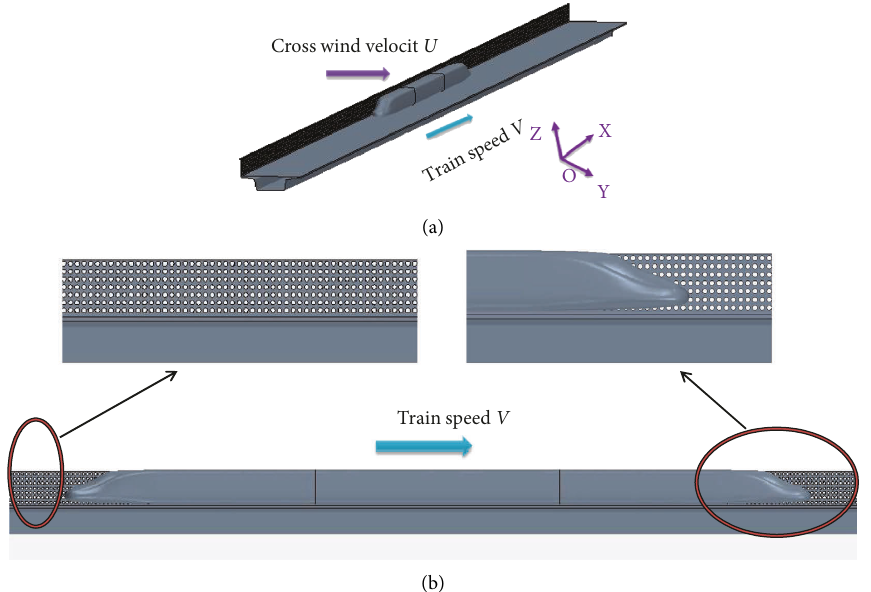
Figure 1: Geometric model composed of wind barriers, cars, and